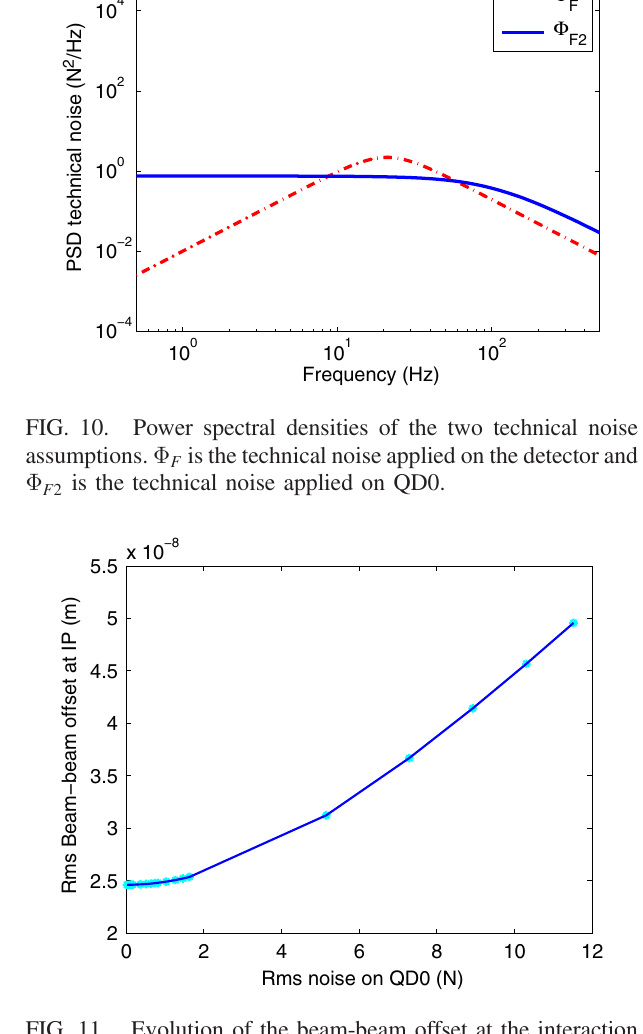
FIG. 11. Evolution of the beam-beam offset at the interaction point σ at 5 Hz as a function of the amplitude of the technical y noise on